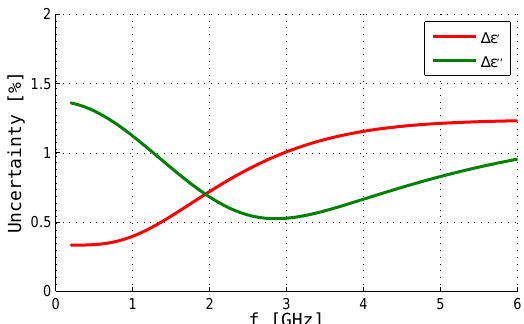
Figure A1. Uncertainty of methanol permittivity (T = 20.6 ◦ C).